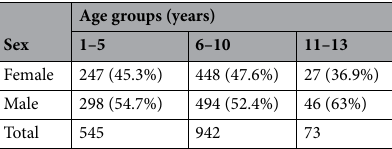
Table 1. Sex and age distribution among the study participants in selected villages surrounding Lake Nyasa, north-western